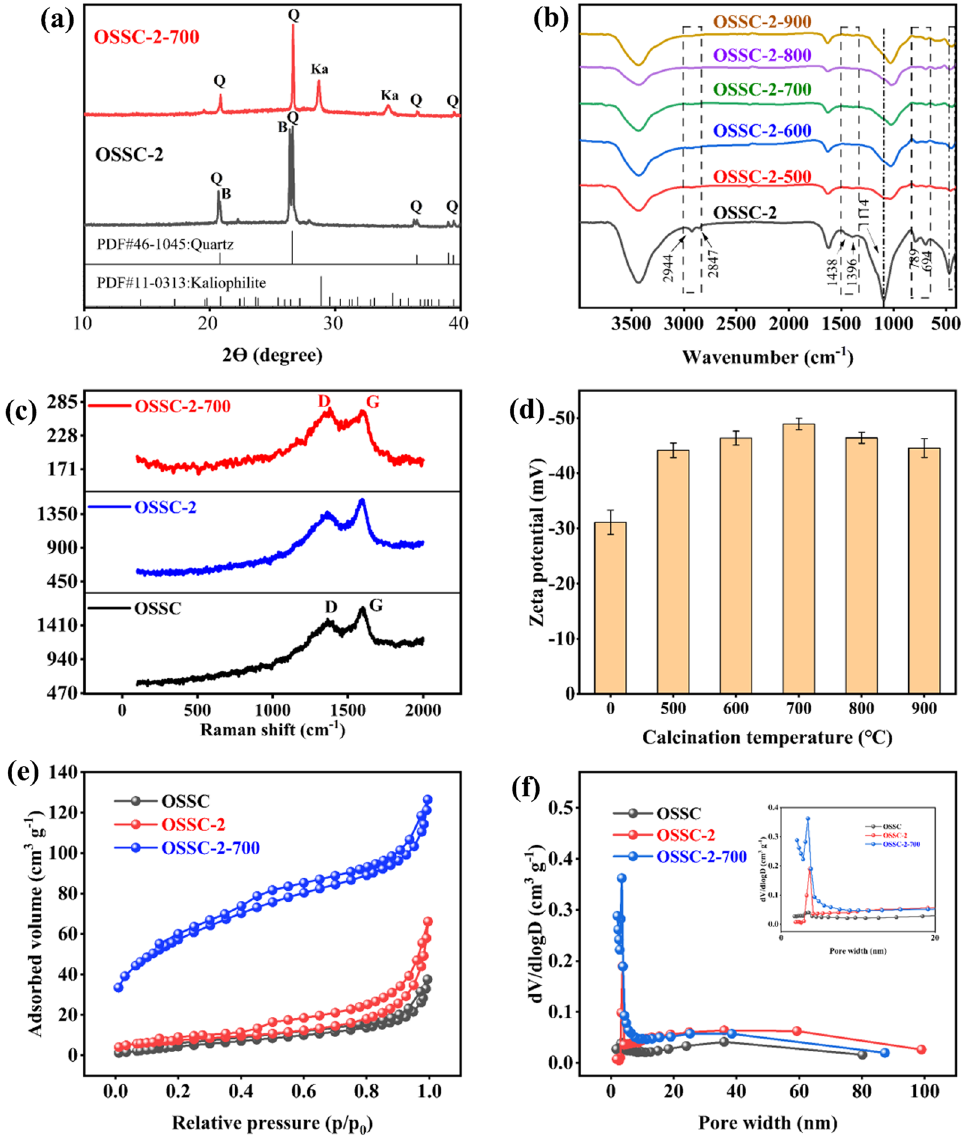
Fig. 4 a XRD patterns, b FTIR spectra, c Raman spectra, d zeta potential, e N 2 adsorption–desorption isotherms and f pore size distribution curves of different samples prepared by two steps. B, Q and Ka denote aluminum phosphate, quartz and kaliophilite,